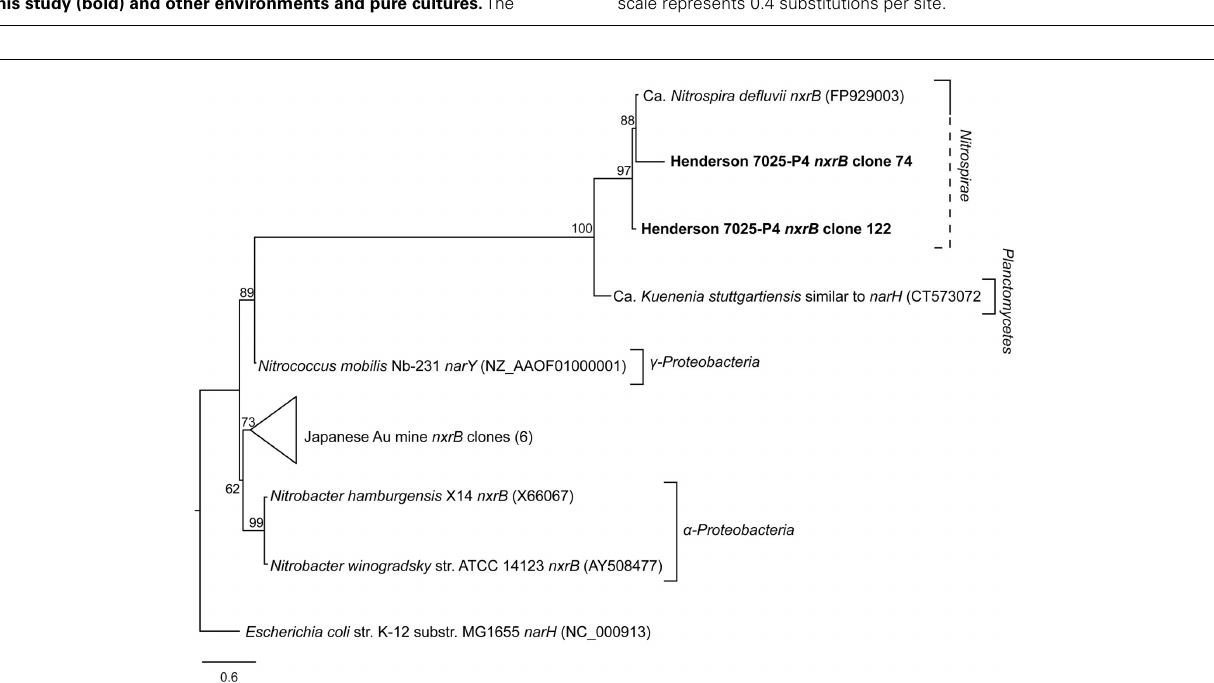
FIGURE 4 | Best-scoring maximum-likelihood phylogenetic analysis of amino acid sequences for nxrB and related nar genes. The Henderson nxrB amino acid sequences retrieved in this study, clones 74 and 122 (bold) are highly similar to the sequence of nxrB in Ca. Nitrospira defluvii , and this